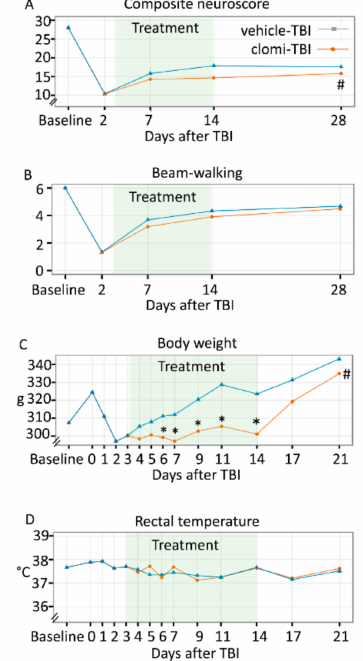
Figure 3. E ff ect of test compounds on in vivo functional outcomes. E ff ects of vehicle ( n = 15) and clomipramine (Clomi, n = 11) treatments on composite neuroscore, beam-walking, body weight and rectal temperature in rats with traumatic brain injury (TBI) were analysed using coe ffi cient estimates of the linear mixed e ff ects model. The treatment period (3–14 days) is indicated with a light green area in each panel. ( A ) Clomipramine administration impaired performance in the composite neuroscore test compared with vehicle treatment. ( B ) Performance in the beam-walking test was comparable between the Vehicle-TBI and Clomi-TBI groups. ( C ) Clomipramine delayed the post-TBI weight gain during the 3–14-days treatment period. After clomipramine discontinuation, rats stated to gain weight and by 21 days post-TBI, their weight did not di ff er from that in the vehicle group. ( D ) Rectal temperature was comparable in the Vehicle-TBI and Clomi-TBI groups throughout the entire study period. Statistical significance from: # p < 0.05 (significant main e ff ects model); * p < 0.05 (significant estimates in